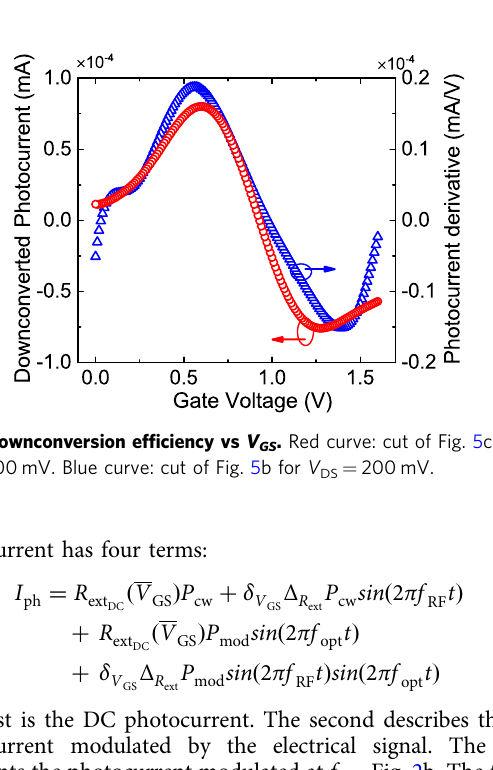
Fig. 7 Comparison between measured and calculated photoconductivity. a Measured and b calculated photoconductivity of illuminated SLG